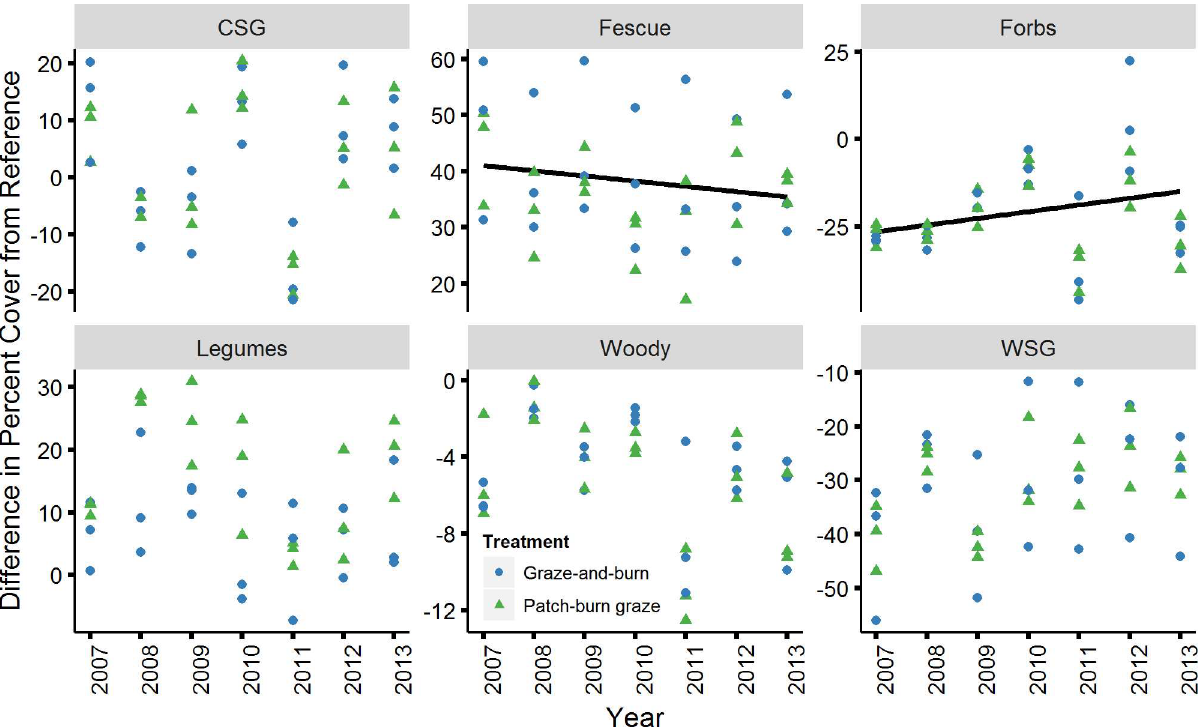
Fig 3. Difference in percent canopy cover of plant functional guilds from reference sites. Abbreviations are as follows, CSG = cool- season grasses (C3), Fescue = tall fescue ( Schedonorus arundinaceus (Schreb.) Dumort., nom. cons.), Forbs = non-leguminous forbs, Legumes = leguminous forbs, Woody = woody vegetation, WSG = warm-season grasses (C4). Linear trends in functional guild cover at degraded sites were tested using the difference between the percent cover at each degradedsite and the averagepercent cover of the two reference sites. Lines depict relationships that were significant when considering Bonferroni correction (p < 0.008). Note : scale on the Y axis is different for each functional guild